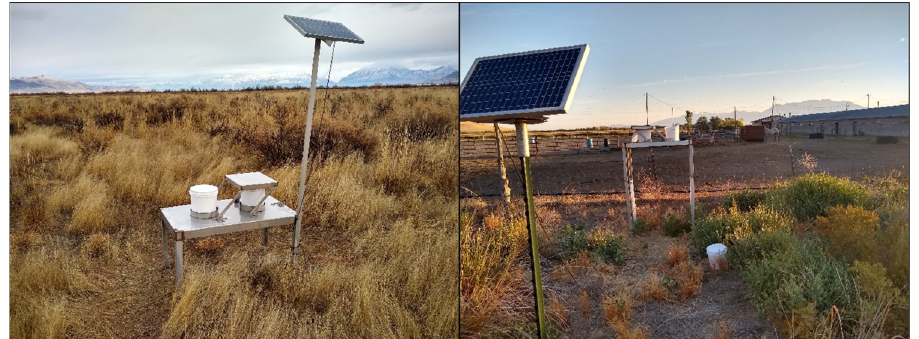
Figure 7. Old solar panel installation shown in the right, with the new, modified installation moving the solar panel 5 m away from the sample table shown on the